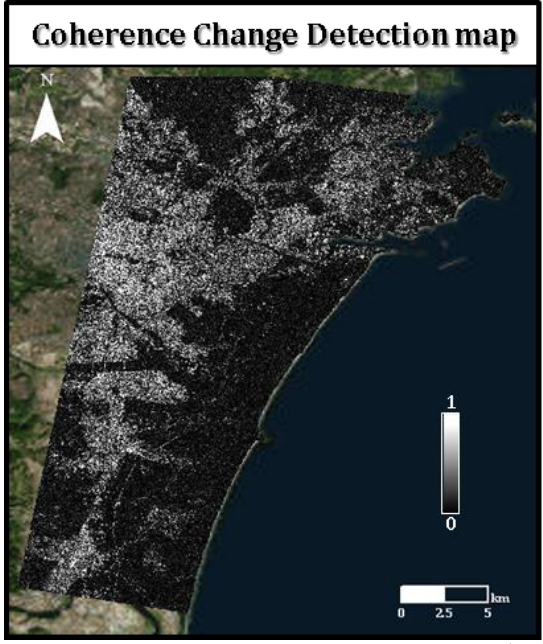
Figure 2. Coherence change detection map. High values (close to 1, white in the scale) represents no change=stability. Observed mostly in urban areas. Low Values (close to 0, black) represent severe damage, appears mostly along the coastline.